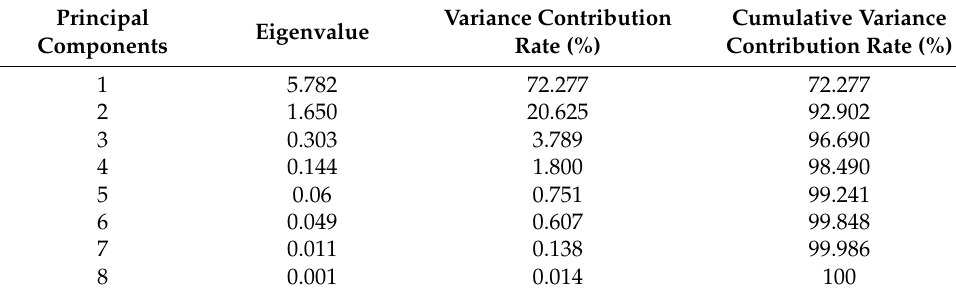
Table 3. Eigenvalues and contribution of principal